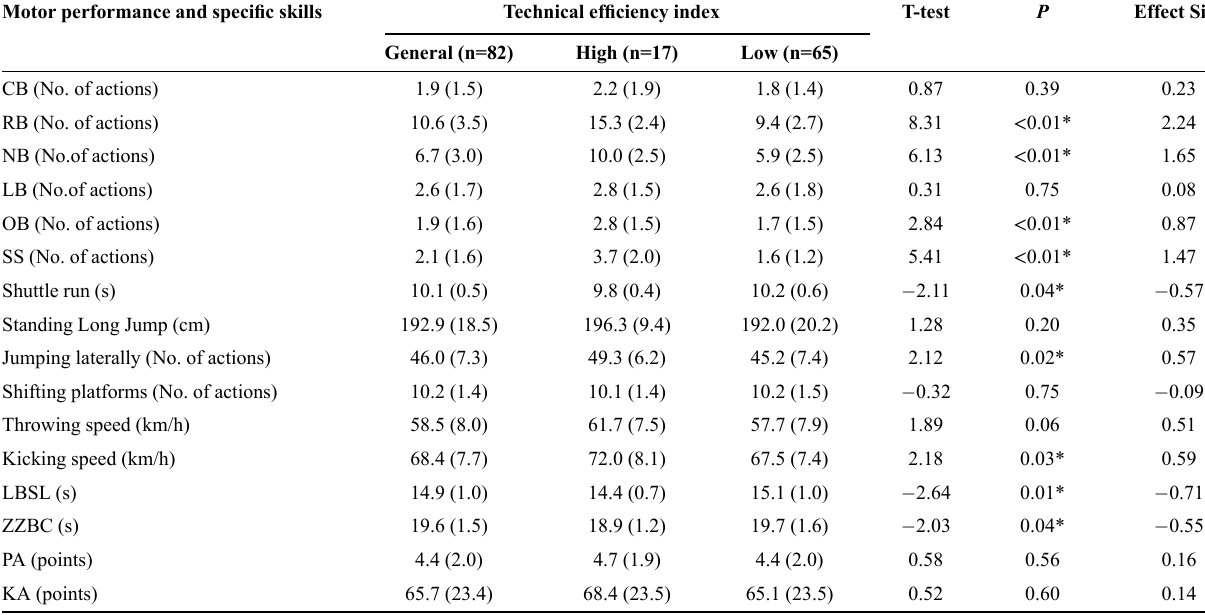
Table 2 - Technical actions, motor performance, and specific skills for groups of High- and low-frequency of technical actions (Mean and SD). Motor performance and specific skills